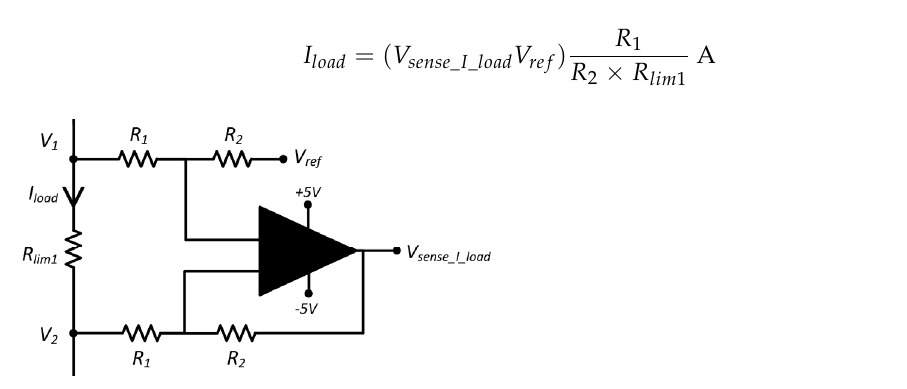
Figure 16. Differential amplifier circuit for leakage current measurement.